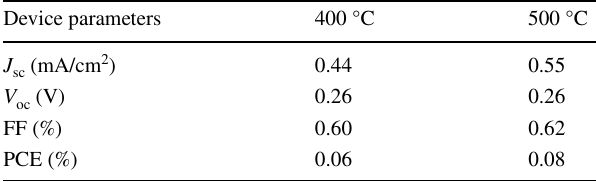
Table 1 Solar cell parameters at different annealing temperature Device